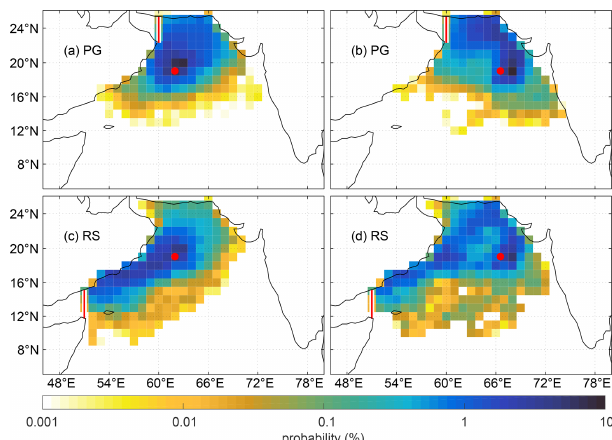
Figure 8. Lagrangian particle position probability maps show the most pronounced pathways of fluid particles along the isopycnal σ = 27kgm − 3 for the backward-trajectory analysis, entering the Persian Gulf from (a) WR and (b) ER and the Red Sea from (c) WR and (d) ER. Eastern (ER) and western target (WR) locations in the OMZ are marked in red, as are the sections that need to be crossed to define the source